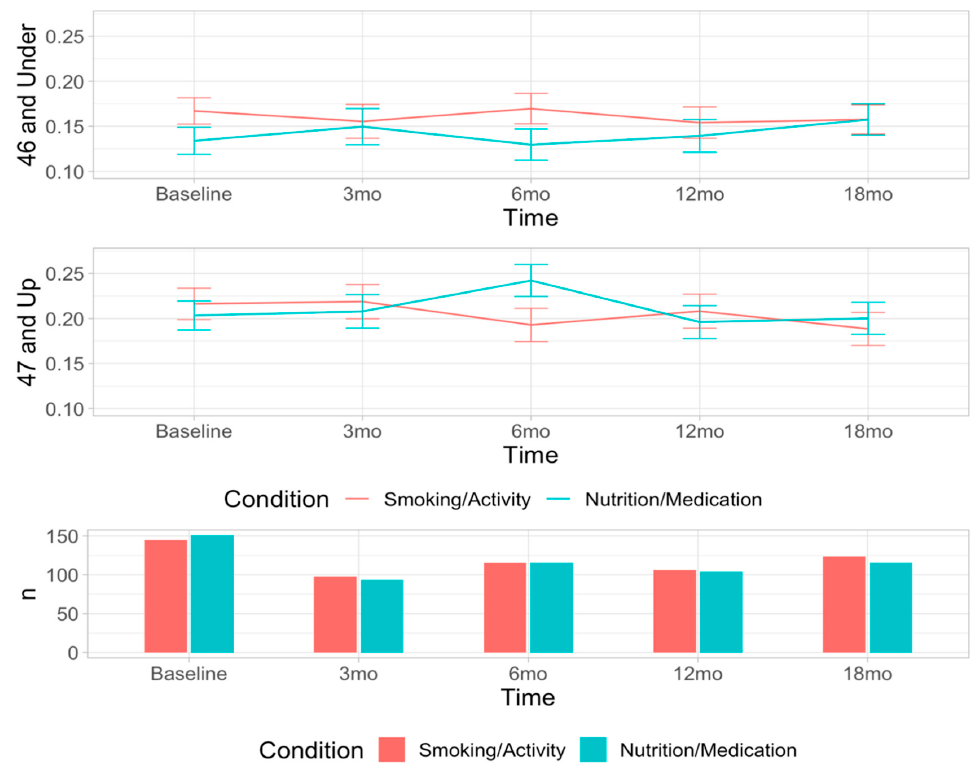
Figure 2. Heart-healthy foods ratio by condition at each time point. Means and standard deviations for the ratio of heart-healthy food servings reported/total servings of foods reported are depicted for each condition at each time point. The sample size of those who filled out the survey at each time point are depicted in the bar chart below the graph.